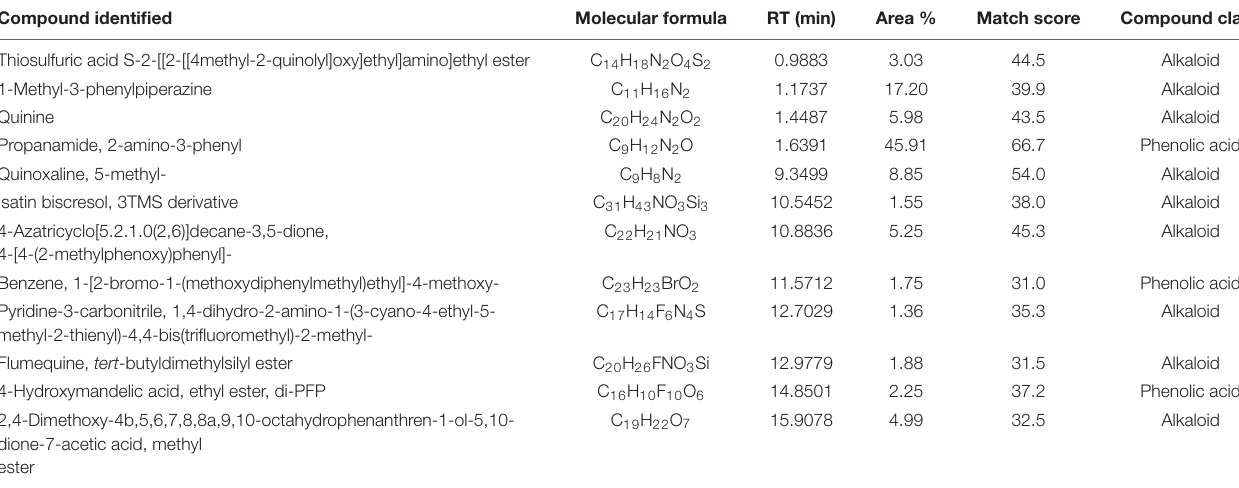
TABLE 6 | Most abundant compounds identified by LC-MS in sorghum